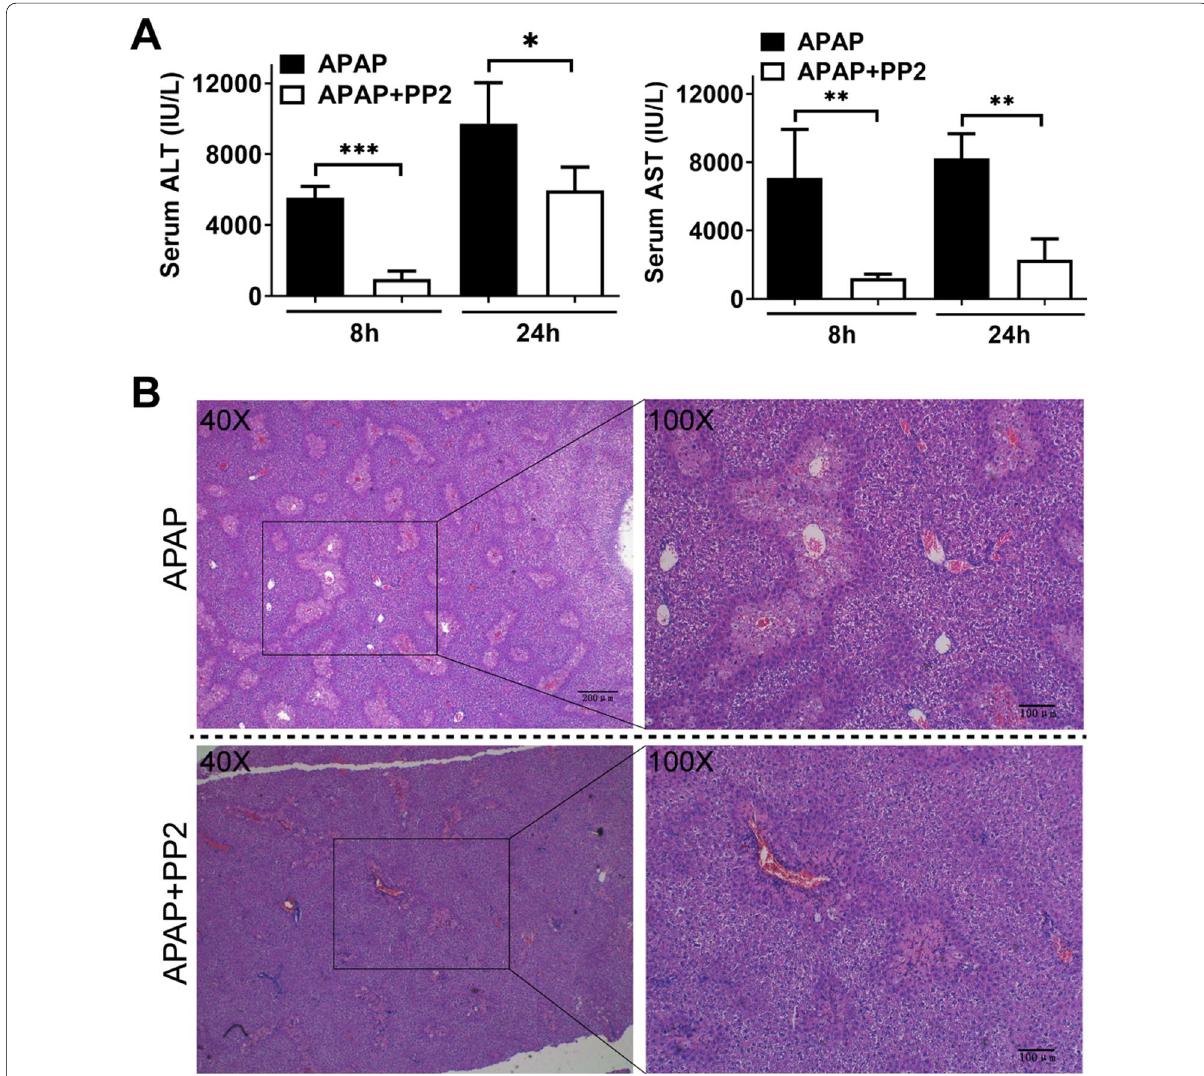
Fig.7 Treatment with PP2 attenuated APAP induced liver injury. A Male C57 mice were starved for 16 h and i.p. injected with/without PP2 (1.5 mg/ kg) prior to APAP administration (300 mg/kg). Serum was collected after 8 h and 24 h for ALT and AST measurement. B H&E staining in liver section from the mice at 24 h after APAP injection. *P < 0.05, **P < 0.01, ***P < 0.001. N 6 mice per =